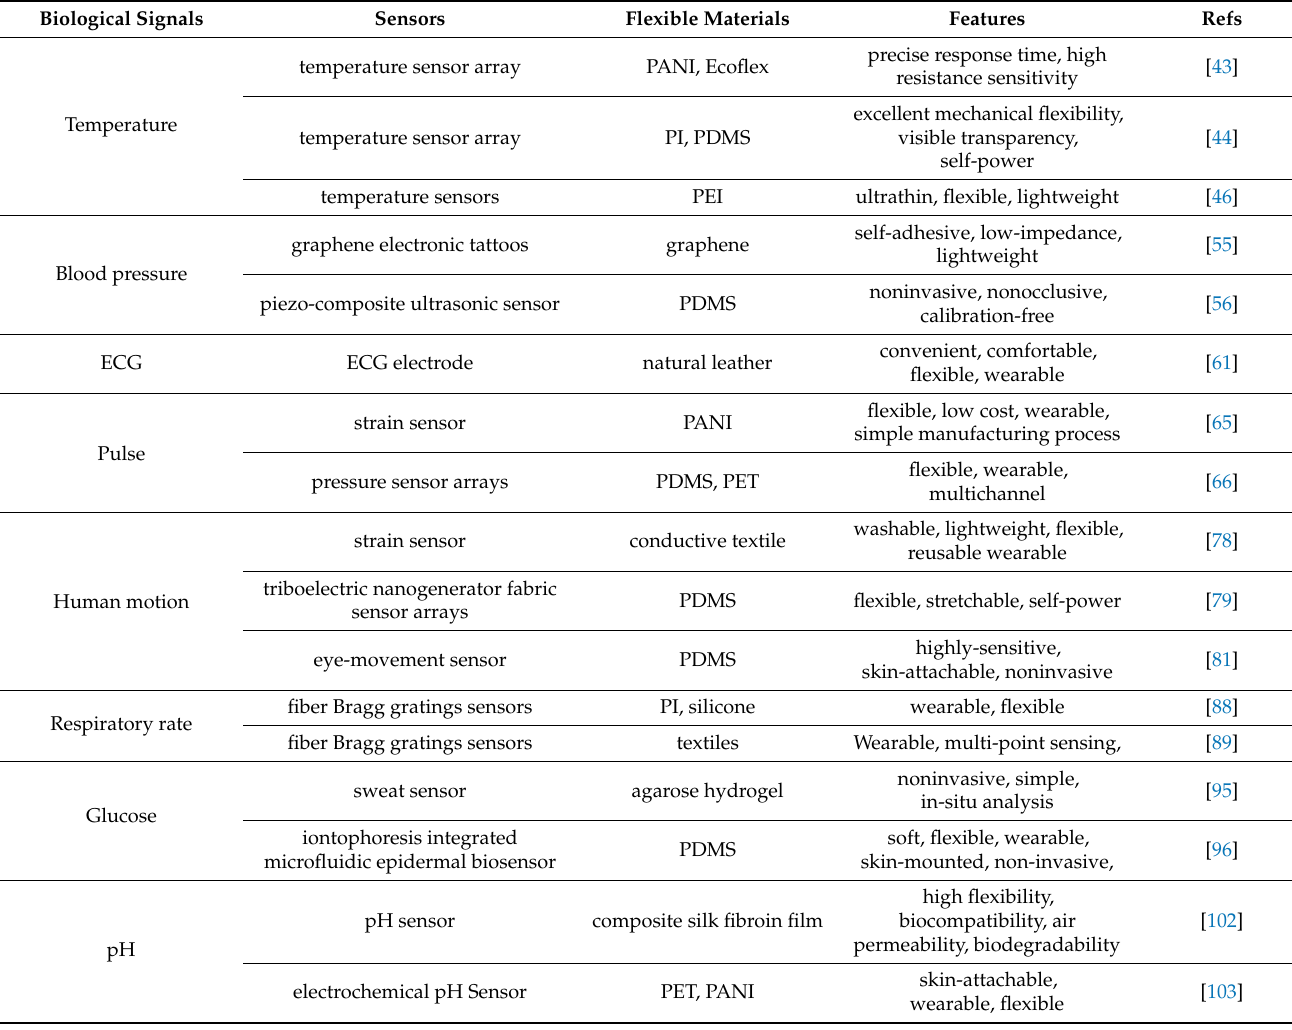
Table 1. Summary of flexible sensors for vital sign